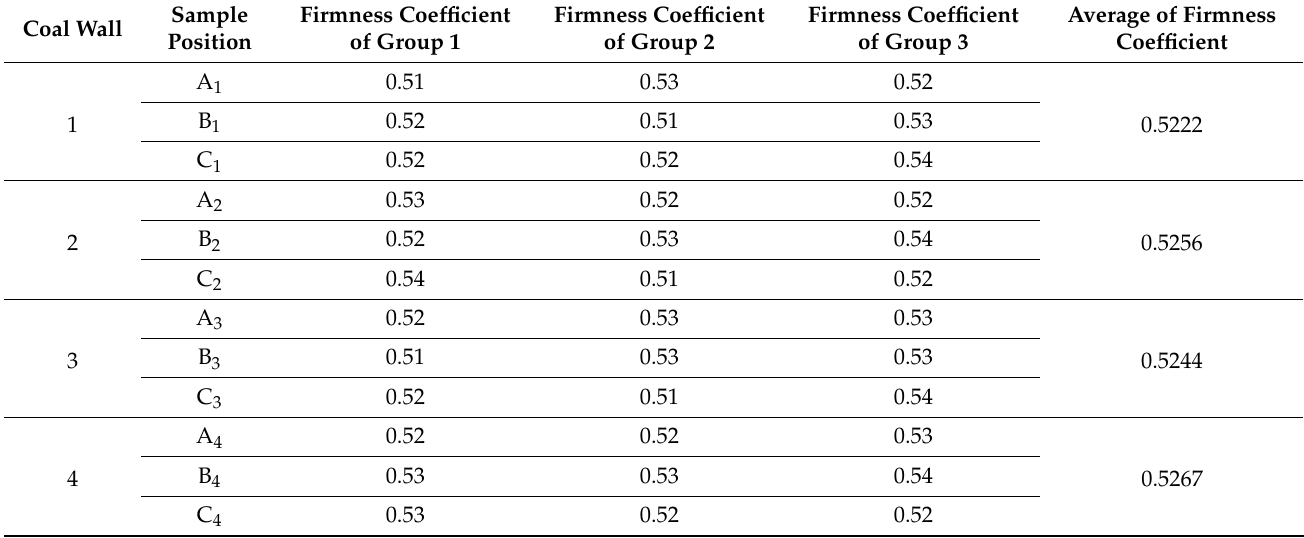
Table 8. Firmness coefficient of the coal